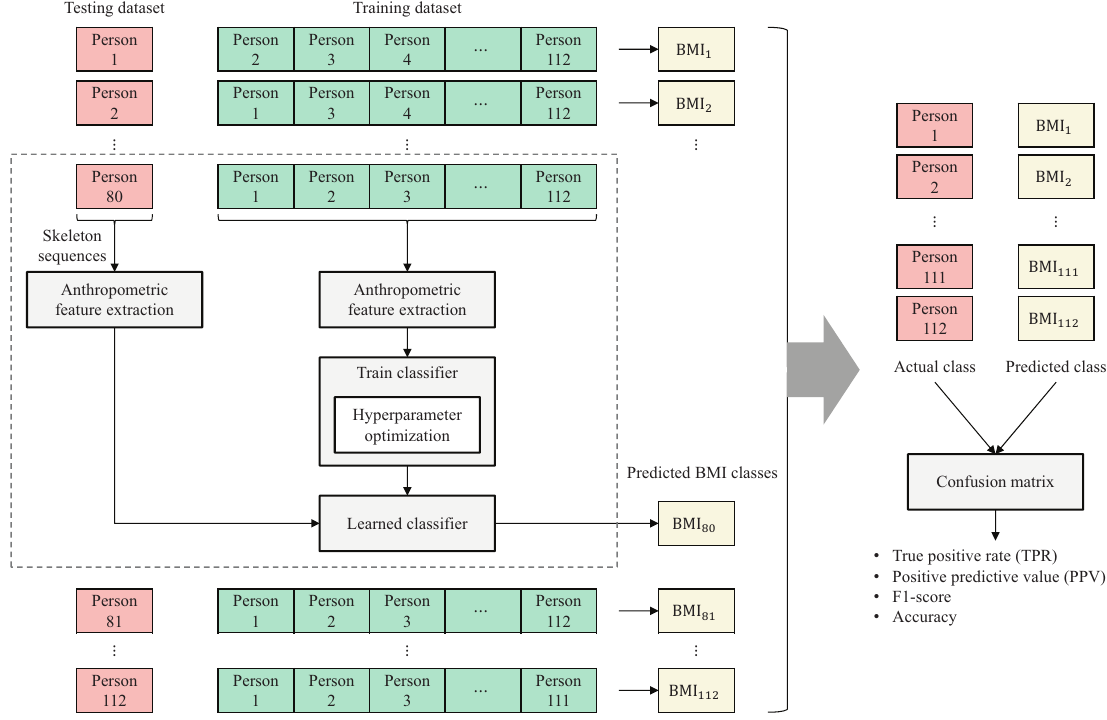
Figure 8. Leave-one-person-out cross-validation process to evaluate the performance of each method. Table 10 shows the leave-one-person-out cross-validation results of the five benchmark methods when the undersampling technique was used. On the other hand, Table 11 shows the leave-one-person-out cross-validation results when SMOTE was used. By using (12) to